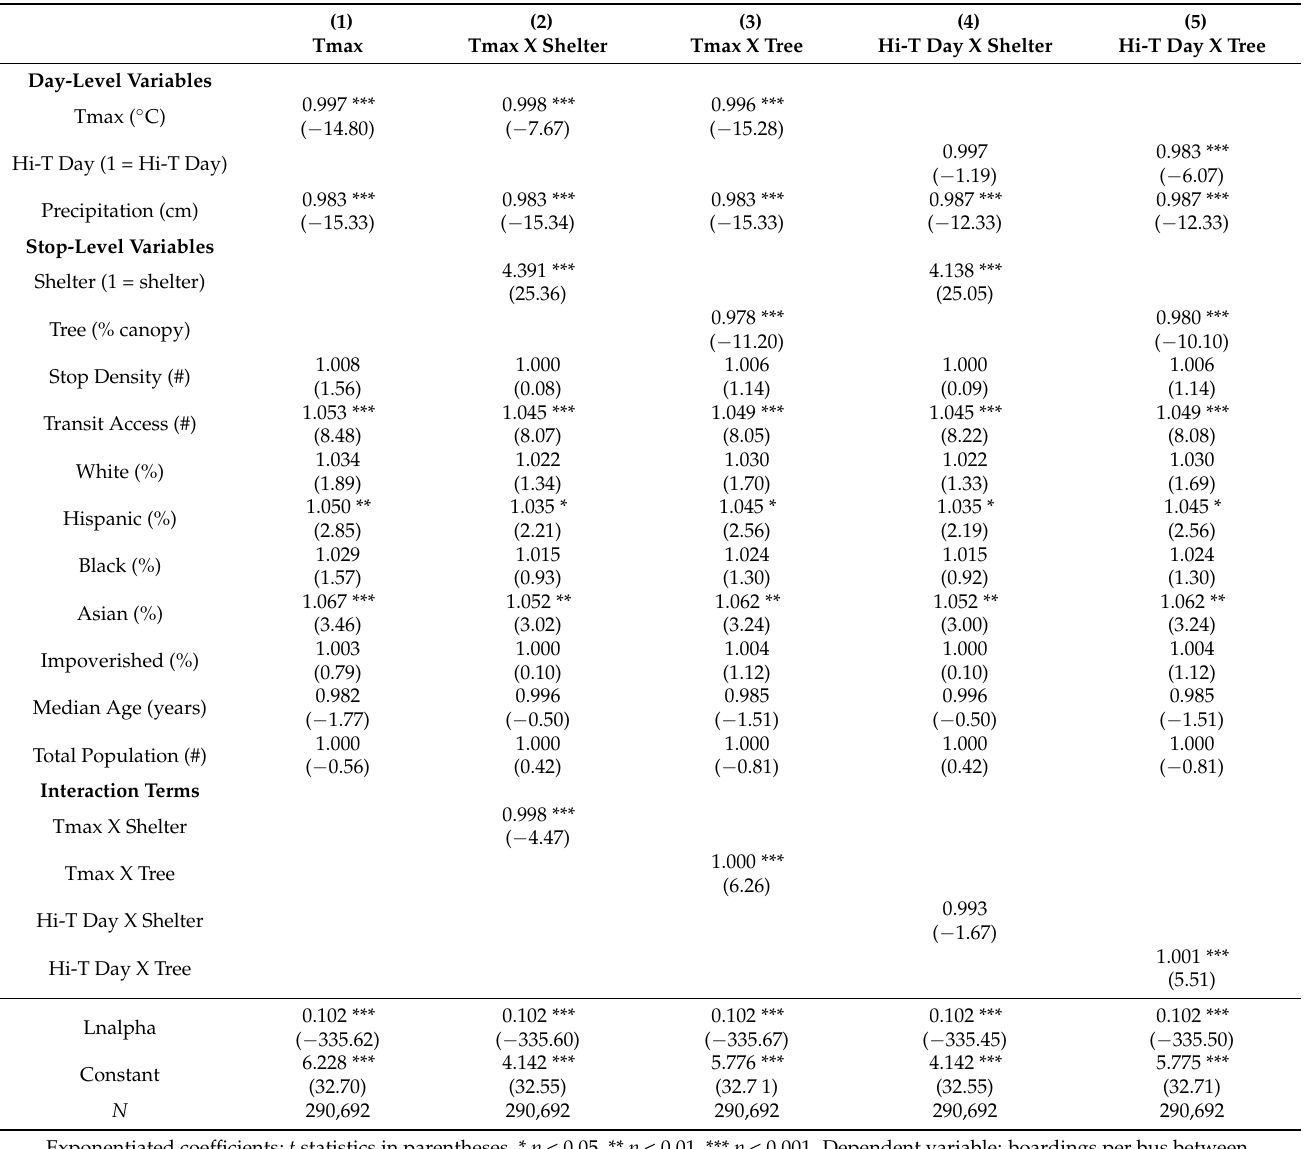
Table 2. Model output for relations between temperature, bus stop shelters, tree canopy, ridership, and